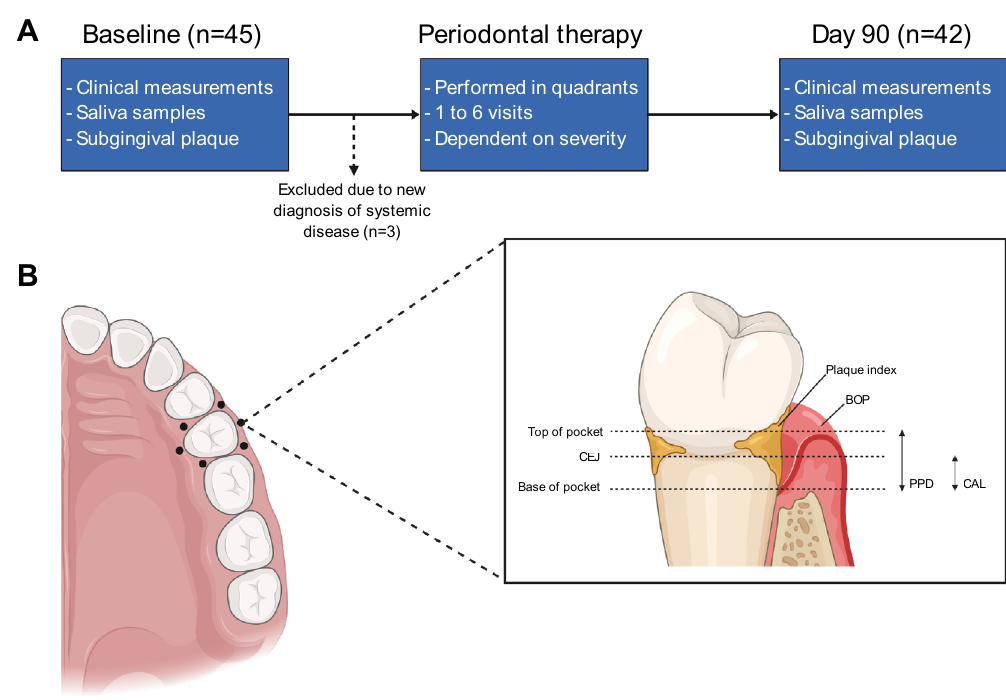
Figure 1. Outlining study protocol ( A ) and collection of periodontal clinical measurements ( B ). Six sites around each tooth were measured for plaque index, BOP, PPD and CAL. CEJ; Cementoenamel